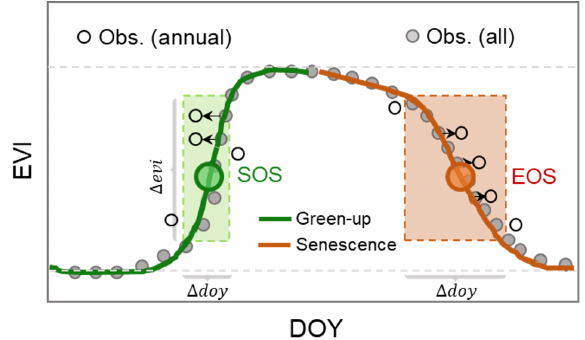
Figure 3. Illustration of the generalized Landsat phenology (GLP) approach for identifying the annual variability of phenology indi- cators. The solid circles are long-term enhanced vegetation index (EVI) observations and the empty circles are observations at a spe- cific year. The shaded frames colored as green and brown are the rational ranges of day of year (DOY) and EVI to be used during the green-up and senescence phases,